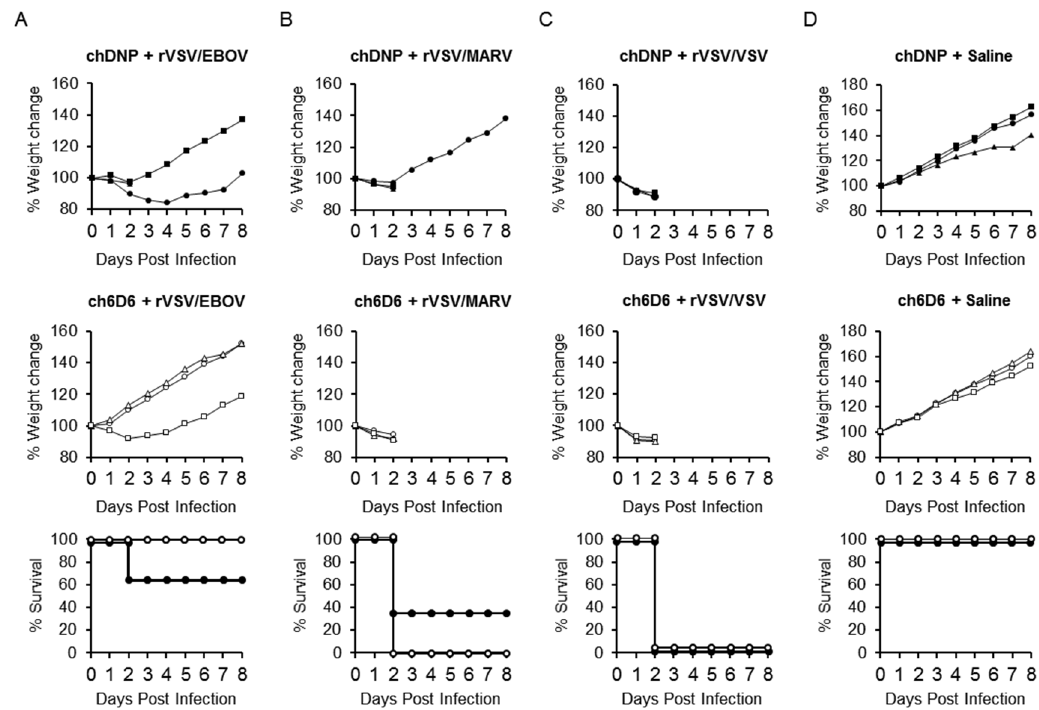
Figure 6. Effects of prophylactic treatment with the neutralizing antibody in rVSV/EBOV-infected hamsters. Three hamsters in each group were treated i.p. with 100 µ g of MAb ch6D6 or negative control MAb chDNP one day before ( A ) rVSV/EBOV, ( B ) rVSV/MARV, or ( C ) rVSV/VSV i.p. challenge (10 7 PFU), or ( D ) treated with saline alone. Symbols represent percentages of body weight for each hamster (upper and middle panels). Open and solid symbols represent survival curves of 6D6- and chDNP-treated animals, respectively (lower panel).